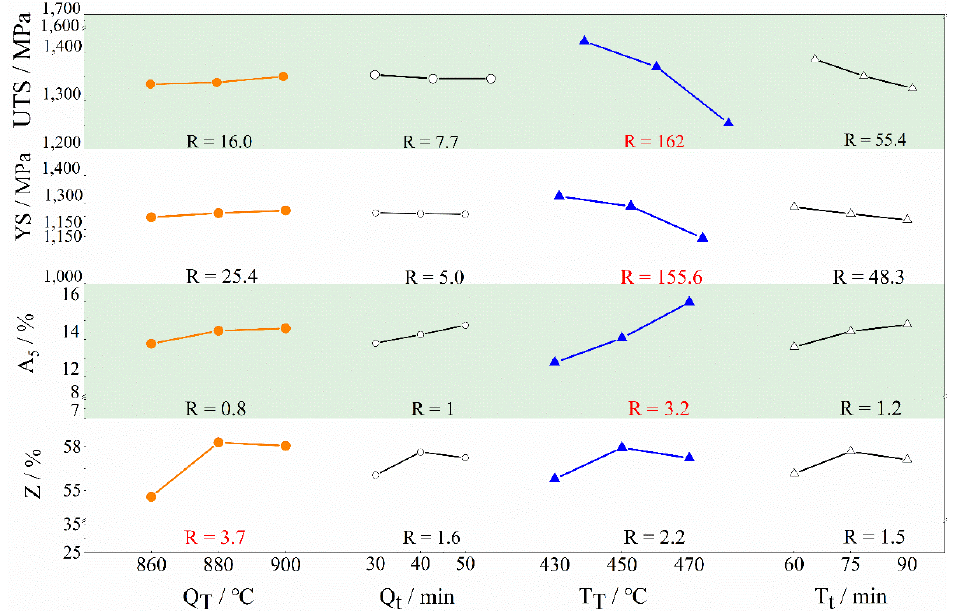
Figure 3. Factors and index trend chart of range analysis: quenching temperature (Q T ), holding time (Q t ), tempering temperature (T T ), tempering time (T t ).